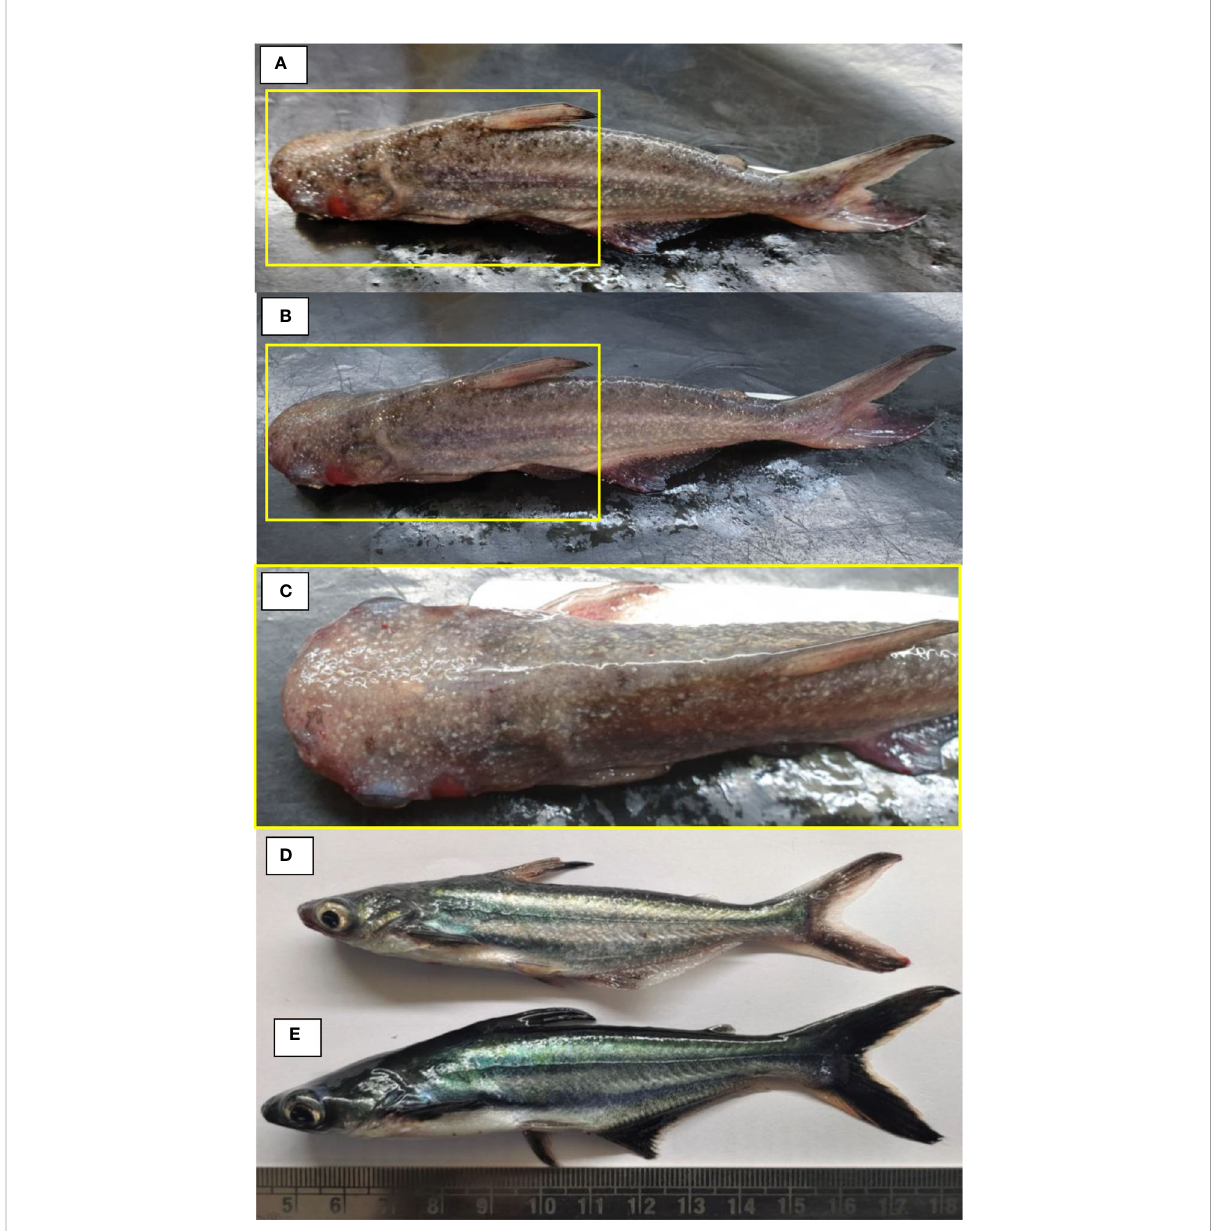
FIGURE 1 The experimental Pangasianodon hypophthalmus used in the study. (A – D) Fish showing signs of the disease, including presence of white spot, hemorrhage, ulcer, discoloration, and redness in fi ns and all over the body surface. (E) The control fi sh appeared healthy, free from possible infection with no external